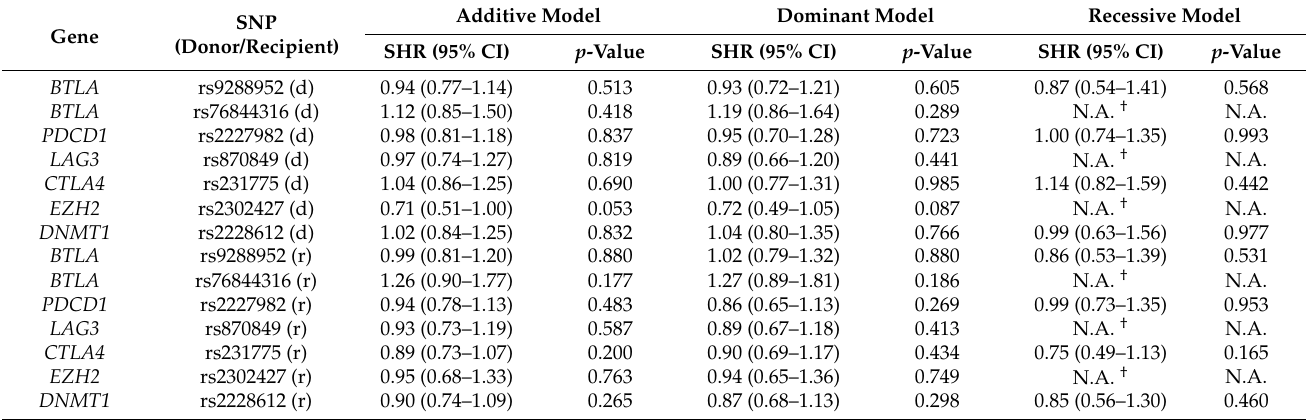
Table 4. Multivariable regression of all chronic GVHD on donor and recipient SNPs.